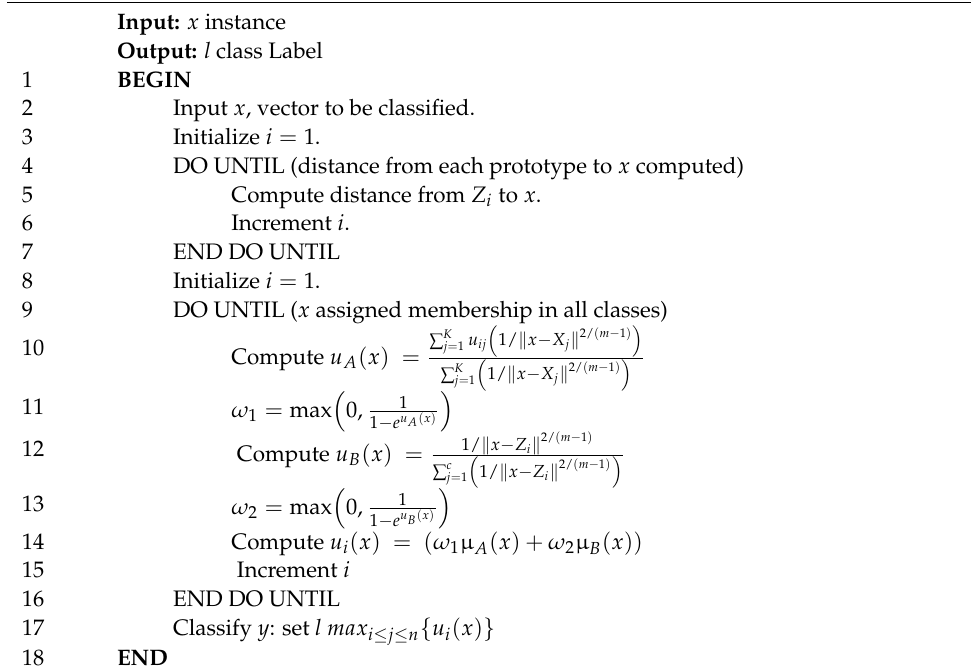
Algorithm 2. Fine-Tuning Fuzzy KNN based on Uncertainty